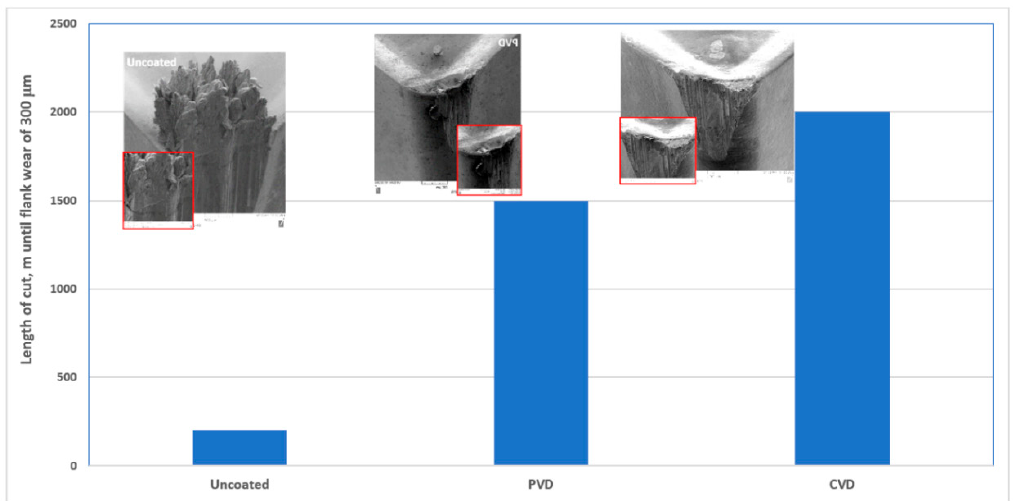
Figure 16. Wear performance data on SS 304 machining with built-up edge formation on the friction surface of coated carbide tools: flank wear vs. length of cut, m with Scanning Electron Microscope (SEM) studies of the worn surface at the end of tool life. Reproduced from [9], with permission from Elsevier, 2020. coatings / carbide substrates [9]. (Reproduced from [9], with permission from publisher Elsevier,